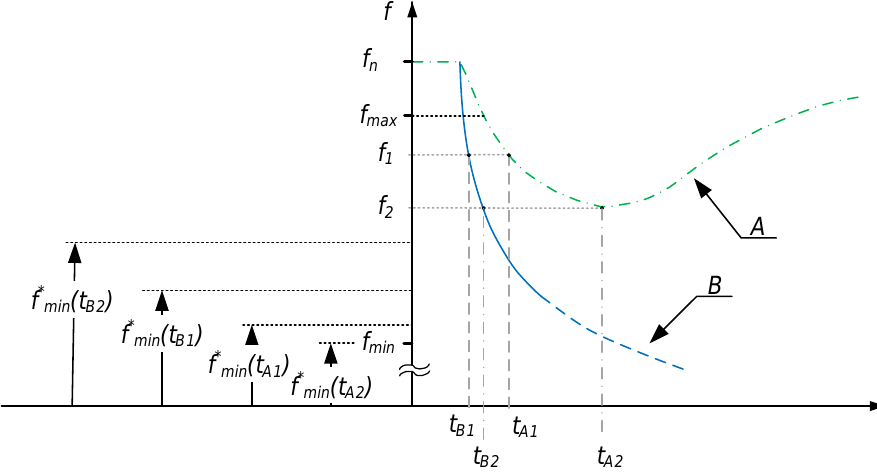
∗ depending on the actual frequency 𝑓 depending on the actual frequency f and min 𝑚𝑖𝑛